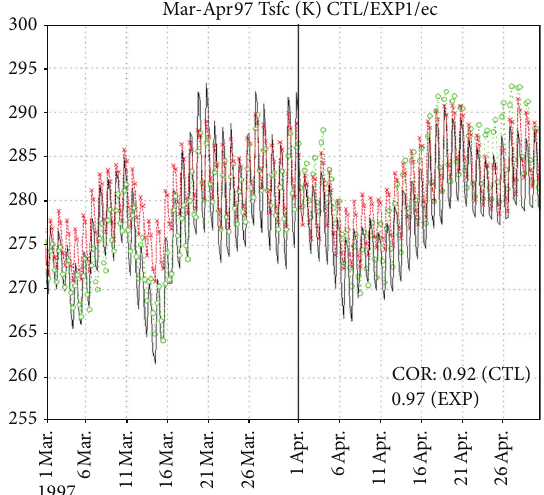
Figure 5: Same as Figure 4 except for surface air temperature [ K ] .